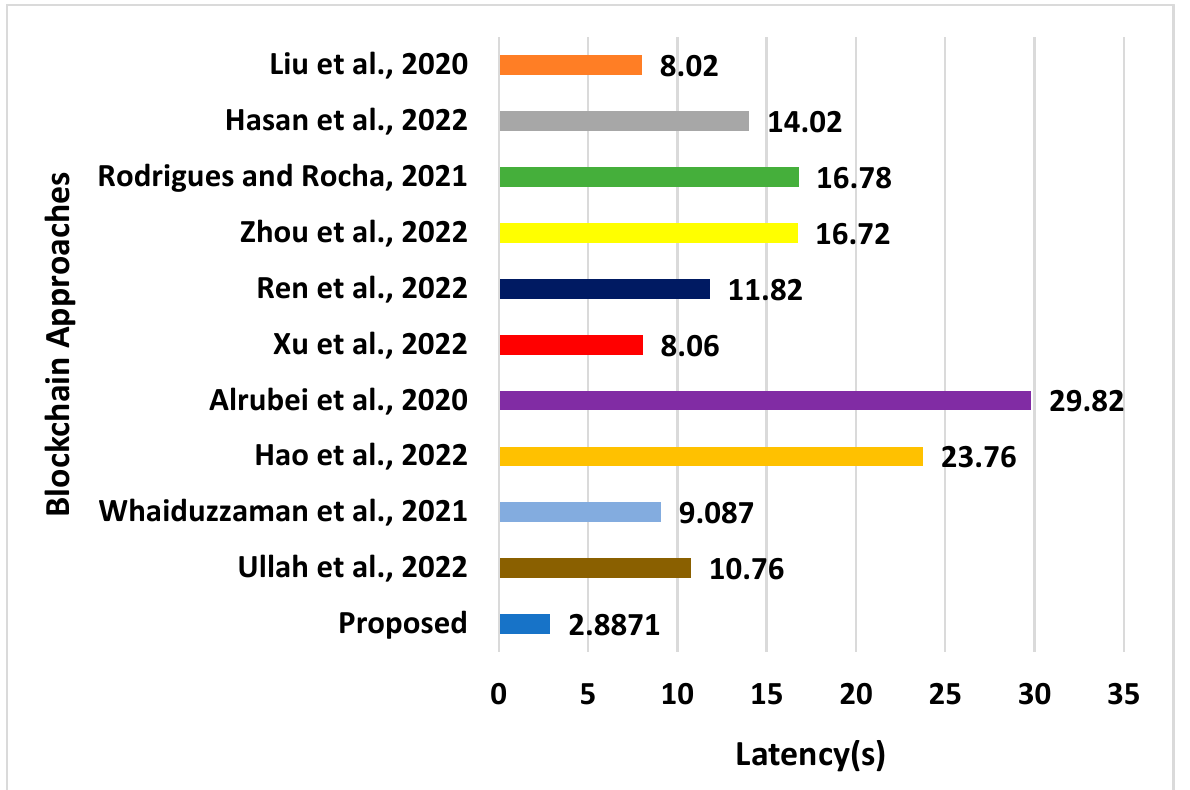
Figure 3. Analysis of latency [39–48].